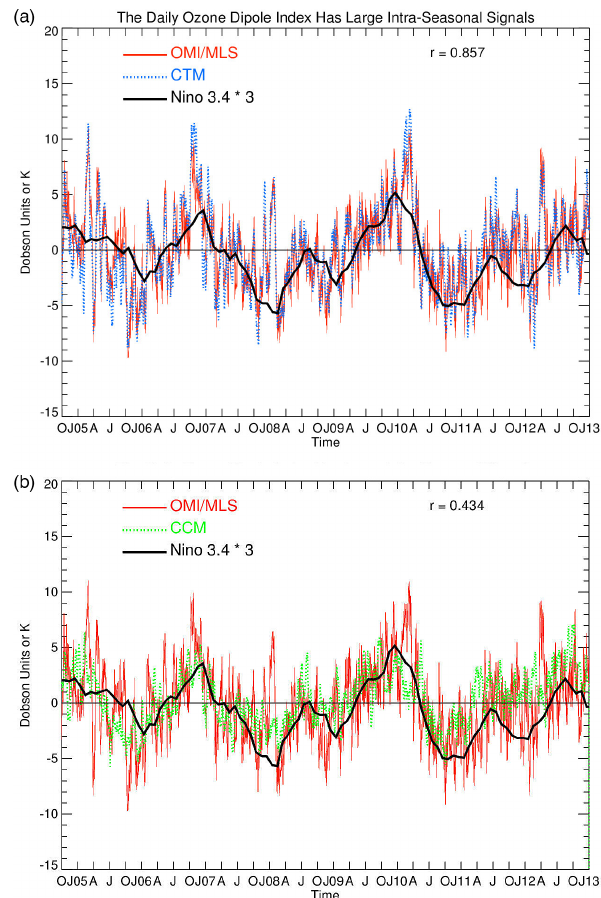
Figure 2. (a) Daily ODI (inDU) for OMI/MLS data (solid red curve) and CTM (dotted blue curve). The beginning labels “O”, “J05”, “A”, and “J” on the horizontal time axis in (a) and (b) denote October, January 2005, April, and July, respectively (similar labels for subsequent years). The monthly-mean Niño 3.4 ENSO index (thick black curve; units K and multiplied by 3 for plotting) is in- cluded for comparison with the two ODI time series. The ODI time series is derived by subtracting the eastern Pacific (15 ◦ S–15 ◦ N, 110–180 ◦ W) from western Pacific (15 ◦ S–15 ◦ N, 70–140 ◦ E) de- seasonalized tropospheric column ozone. The correlation between the two daily ODI time series printed in the upper right of this fig- ure is 0.857. (b) Same as (a) but with the CCM (dotted green curve) in place of CTM. Calculated standard deviations of the ODI time series from OMI/MLS, CTM, and CCM are 3.7, 3.9, and 2.6, re-